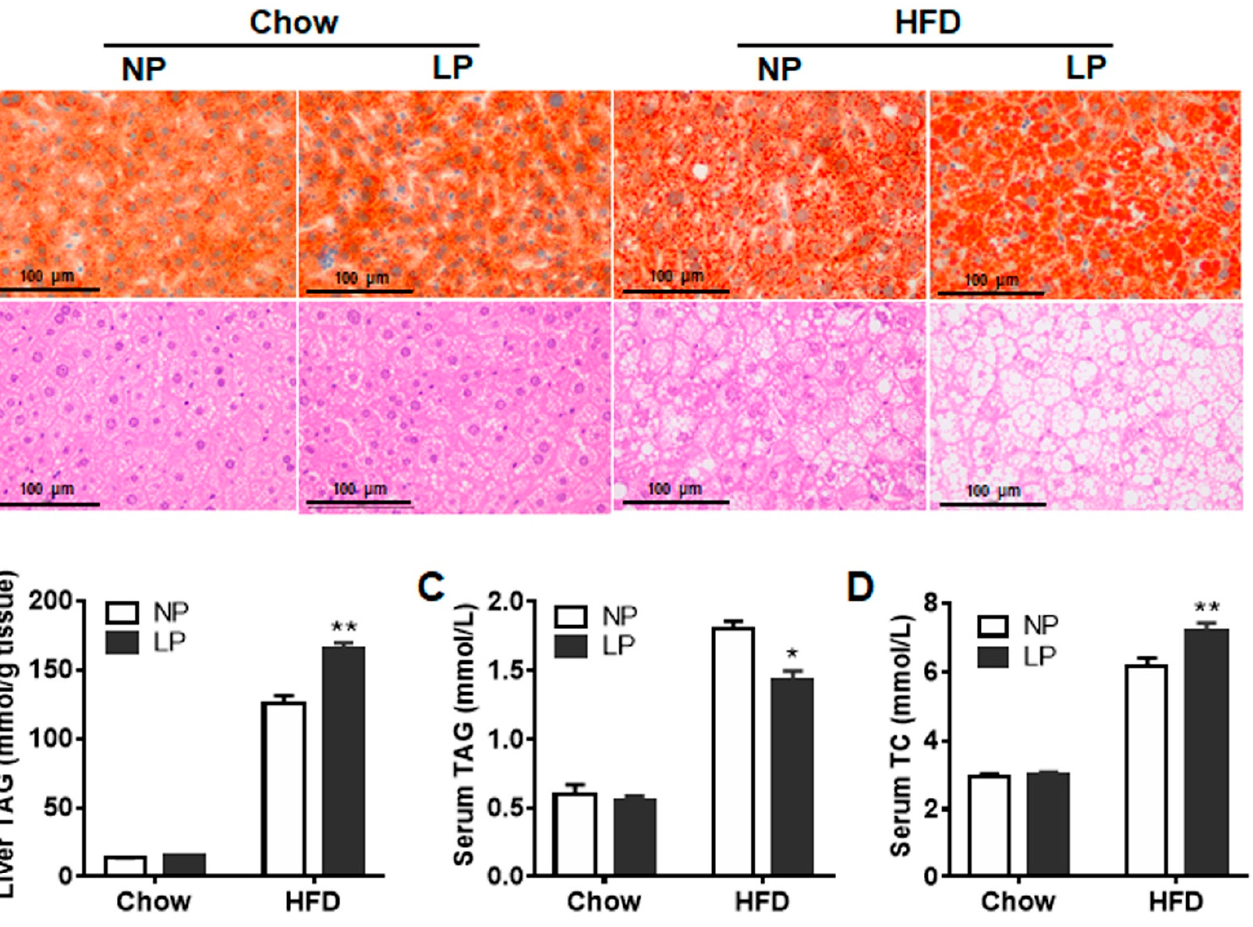
Figure 2. Maternal low-protein diet during puberty and adulthood aggravated hepatic steatosis of offspring under HFD condition. ( A ) Oil-red O staining and H&E staining with the liver of offspring. Bars equal to 100 μ m. ( B ) TAG content in the liver. ( C ) TAG content in the serum. ( D ) TC content in the serum. ( E ) LDL-C content in the serum. ( F ) HDL-C content in the serum. n = 7–9 for each group. Data were expressed as mean ± SE. NP, normal protein diet; LP, low protein diet. * p < 0.05, ** p < 0.01 LP vs. NP. 3.4. Transcriptome Profiling in Offspring’s Liver To identify the potential mechanism involved in the regulation of offspring’s lipid metabolism by a maternal LP diet during puberty and adulthood, we performed tran- scriptome analysis to screen for differentially expressed genes (DEGs) in liver from HFD- fed offspring. In total, 24,800 genes were detected (Supplementary Table S2). With |log2 (fold changes)| > 0 and associated p -values < 0.05, a total of 388 DEGs were identified,